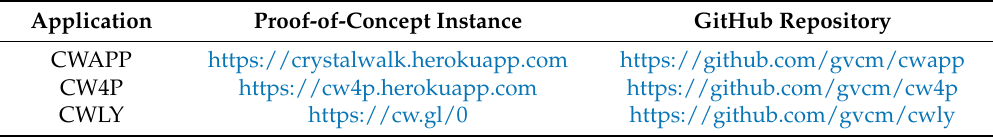
Table 5. CrystalWalk’s applications, deployed proof-of-concept instances and